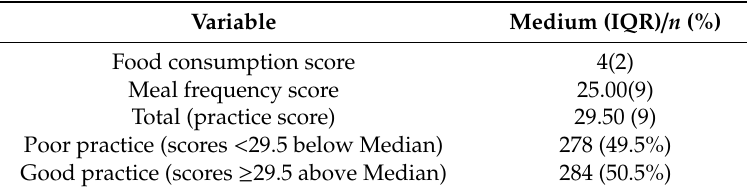
Table 4. Summary of practice towards reducing malnutrition.